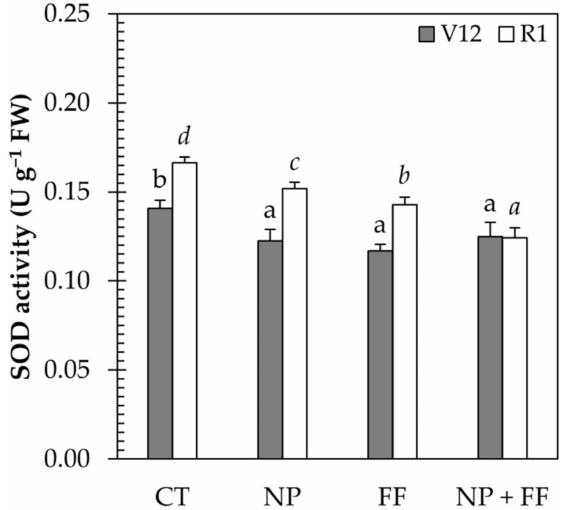
Figure 4. SOD activity osf maize leaves due to each treatment at different phenological stages (V12 and R1). Data represent mean ± SD (n = 5); CT: untreated control; FF: foliar fertilizer; NP: nitrapyrin; NP + FF: joint treatment of nitrapyrin and foliar fertilizer, FW: fresh weight. Different lowercase letters denote significant differences (one-way ANOVA and Duncan’s multiple range test, p ≤ 0.05) between the different treatments.